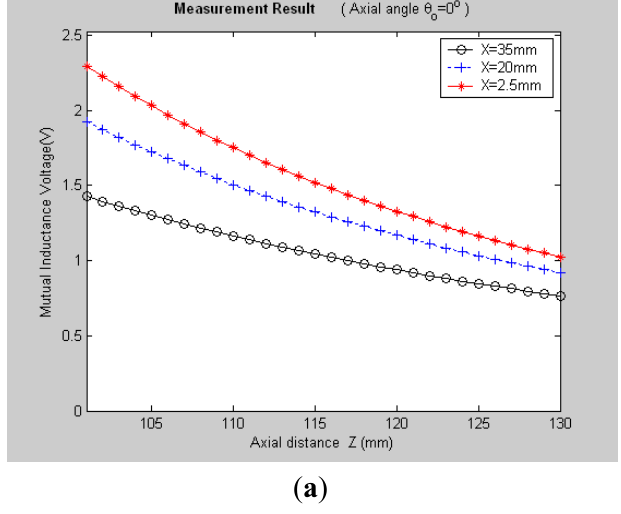
Figure 9. 2-D graphs of ( a ) measured mutual inductance voltage; ( b ) NIELA -based mutual inductance; ( c ) EELA -based mutual inductance versus axial distance Z ( θ Z = 101–130